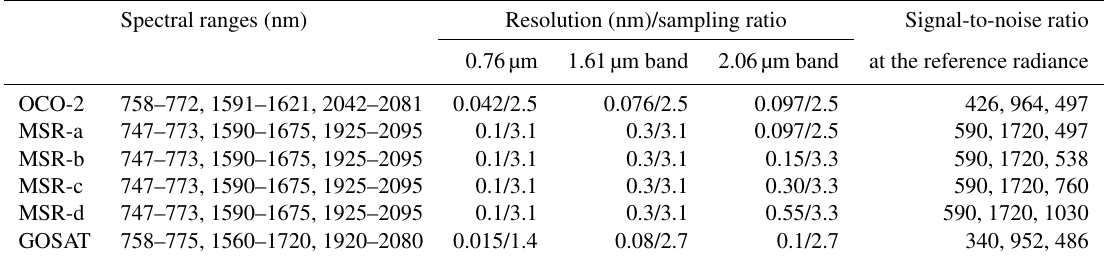
Table 1. Spectral resolutions of the OCO-2 and GOSAT instruments and the four spectral sizing points MSR-a to MSR-d with reduced spectral resolution, which are investigated in this study. Here the spectral sizing point of MSR-d is adapted from the CarbonSat design. The listed signal-to-noise ratios per spectral sampling for each instrument concept are calculated under the same incoming radiance of 75.2, 10.4, and 2.4Wm − 2 srµm − 1 for the 0.76, 1.61, and 2.06µm bands, respectively (Sierk et al.,